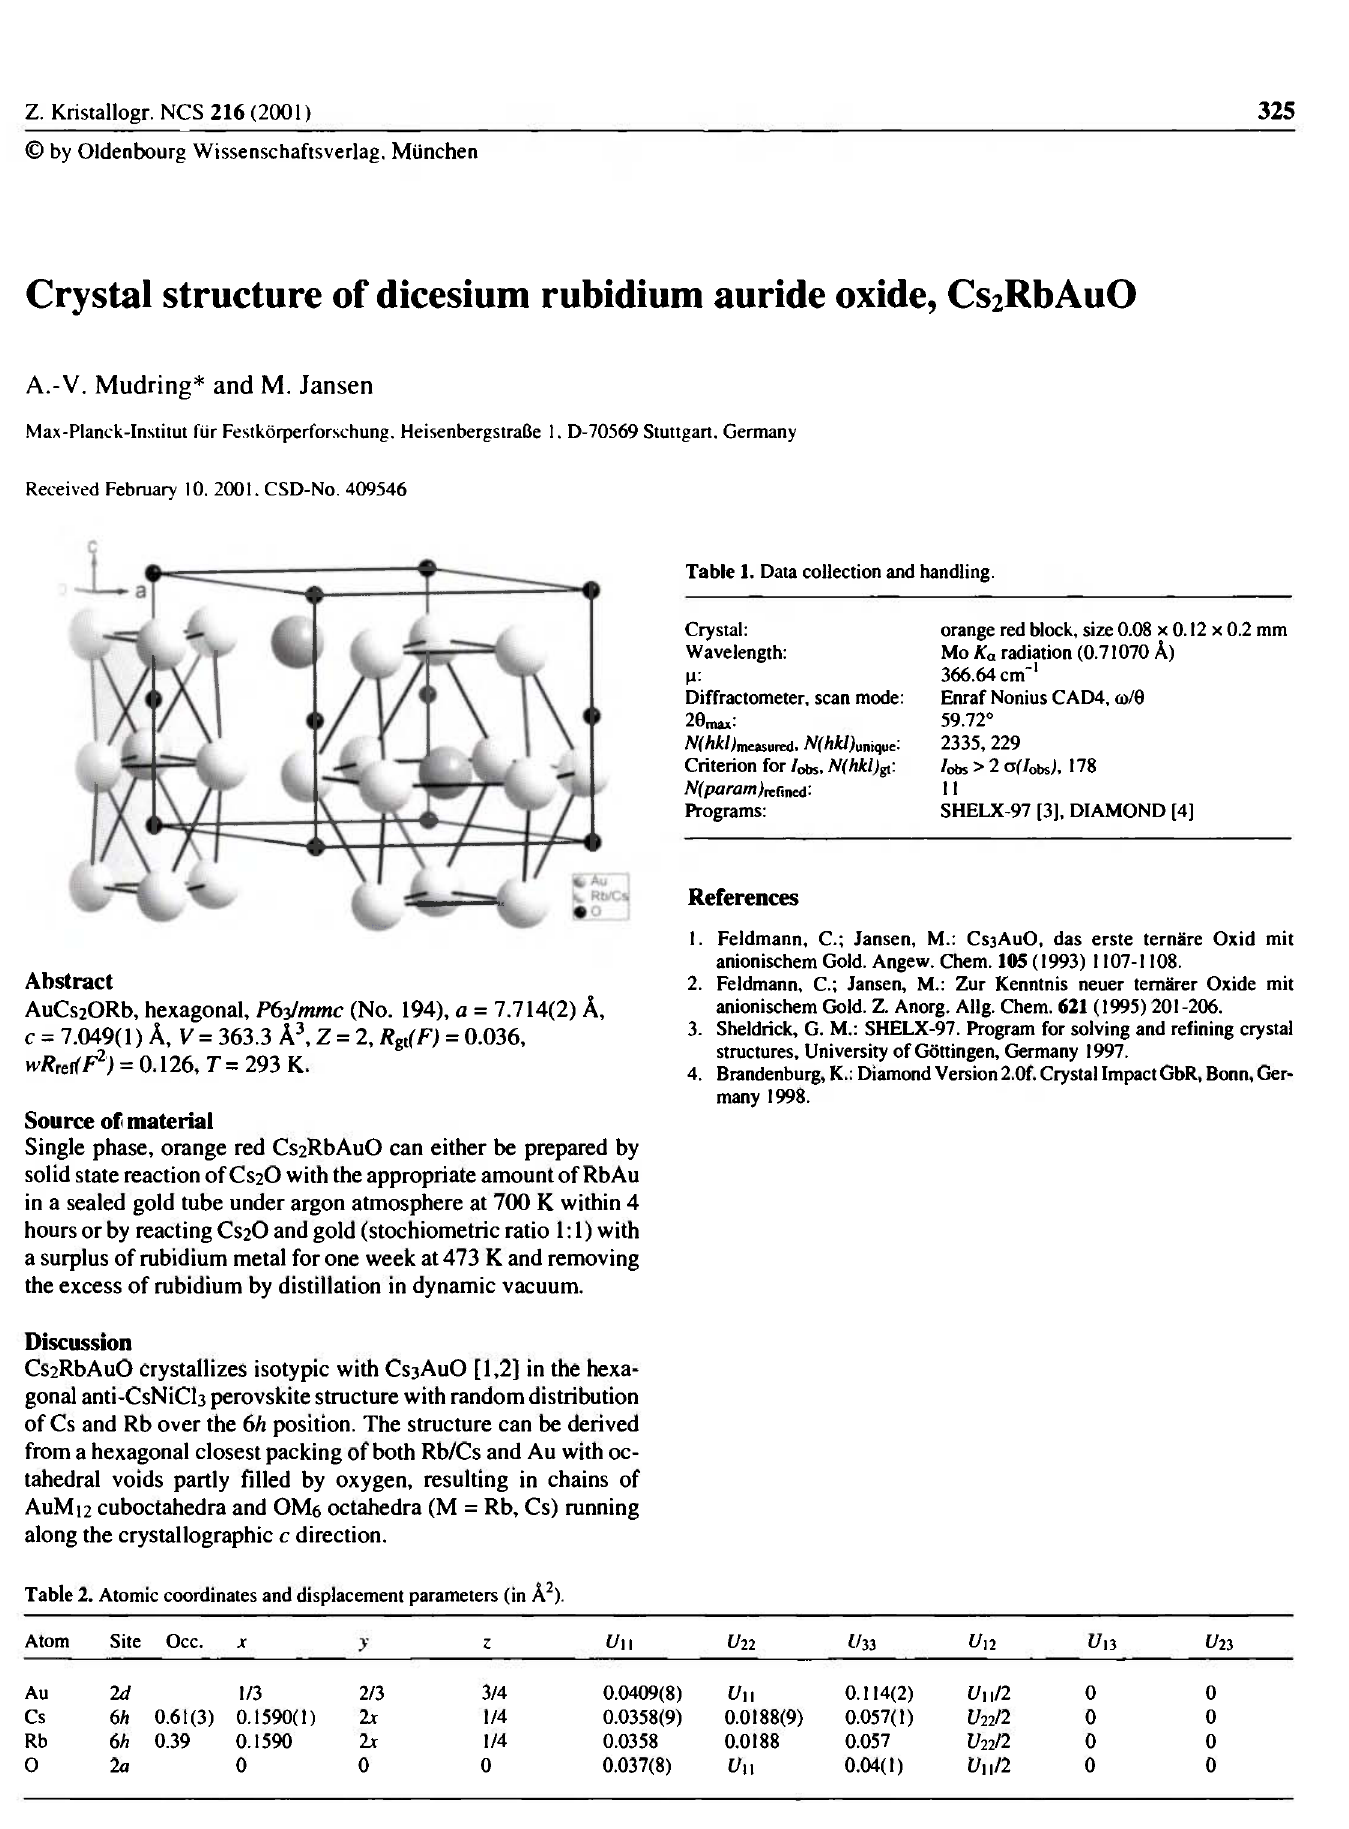
Table 2. Atomic coordinates and displacement parameters (in Ä 2